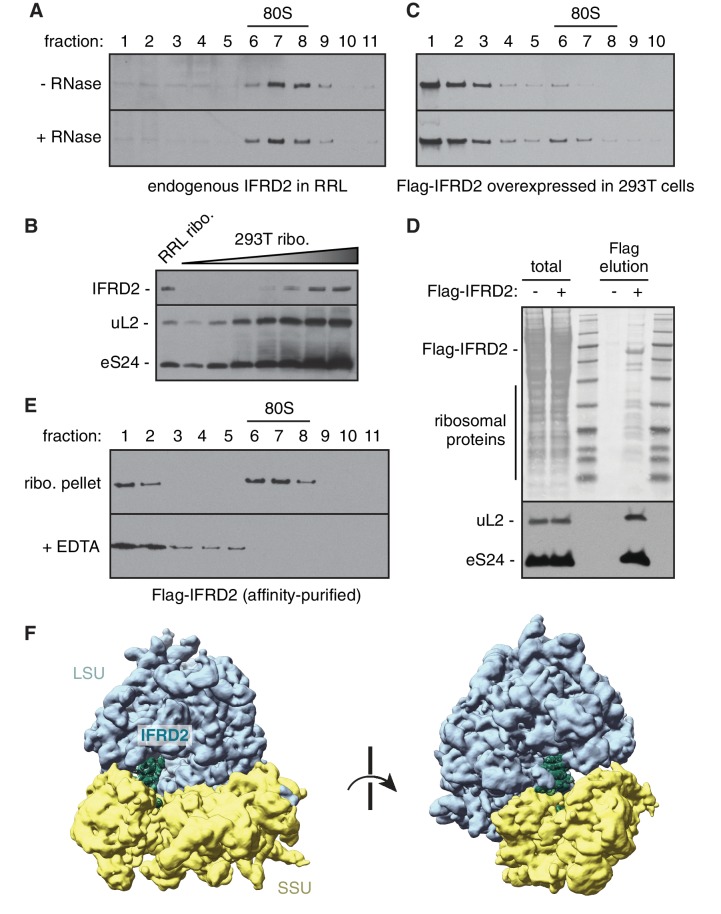
Characteristics of IFRD2 association with mammalian ribosomes.(A) Rabbit reticulocyte lysate was directly treated without or with 50 μg/mL RNase A for 5 min and subjected to size fractionation on a 10 – 50% sucrose gradient. Eleven fractions collected from the top of the gradient were analyzed by SDS-PAGE and immunoblotting for IFRD2. Migration of 80S ribosomes is indicated. Note that all detectable endogenous IFRD2 is in ribosomal fractions. (B) Ribosomes isolated from reticulocyte lysate and HEK293T cell lysate by centrifugation were directly analyzed by SDS-PAGE and immunoblotting for the indicated ribosomal proteins and IFRD2. Comparing 0.2 pmol of reticulocyte ribosomes (lane 1) with a serial twofold titration of HEK293T ribosomes reveals an enrichment of IFRD2 on the former. (C) HEK293T cells overexpressing Flag-tagged IFRD2 were lysed and directly analyzed as in (A) and immunoblotting against the Flag epitope. (D) Lysates from HEK293T cells overexpressing Flag-tagged IFRD2 were subject to affinity purification via the Flag epitope. The elution and 10% equivalent input were analyzed by SDS-PAGE, Ponceau staining (top) and immunoblotting for ribosomal proteins, revealing that IFRD2 copurifies with ribosomes. (E) Ribosomes (ribo.) in the elution in (D) were pelleted and subjected to native size fractionation on a 10–50% gradient without or with 10 mM EDTA. Eleven fractions from the top were collected and analyzed by SDS-PAGE and immunoblotting for Flag-tagged IFRD2. (F) Cryo-EM map of Flag-tagged IFRD2 on human 80S ribosomes, with the model of IFRD2 (Figure 3) docked.